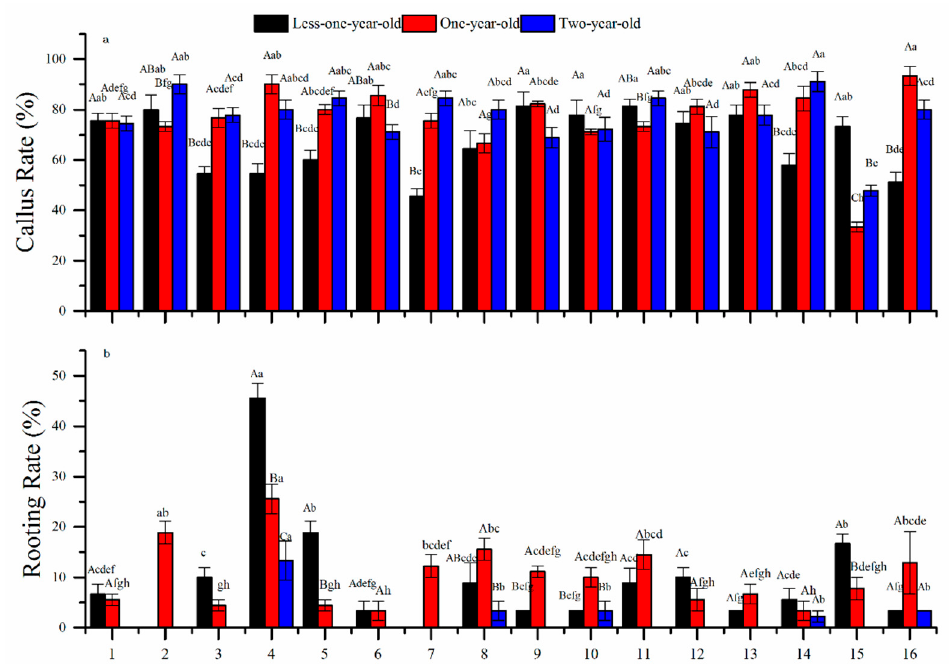
Figure 3. Effects of growth hormones at differing concentrations on the ( a ) callus initiation rate and ( b ) rooting rate of Chinese fir leaf cuttings. Different lowercase letters above the columns indicate significant differences ( p < 0.05) between different treatments. Different capital letters indicate significant differences ( p < 0.05) between different leaf ages. The numbers 1 to 16 on the horizontal axis refer to the 16 treatments in Table 1.